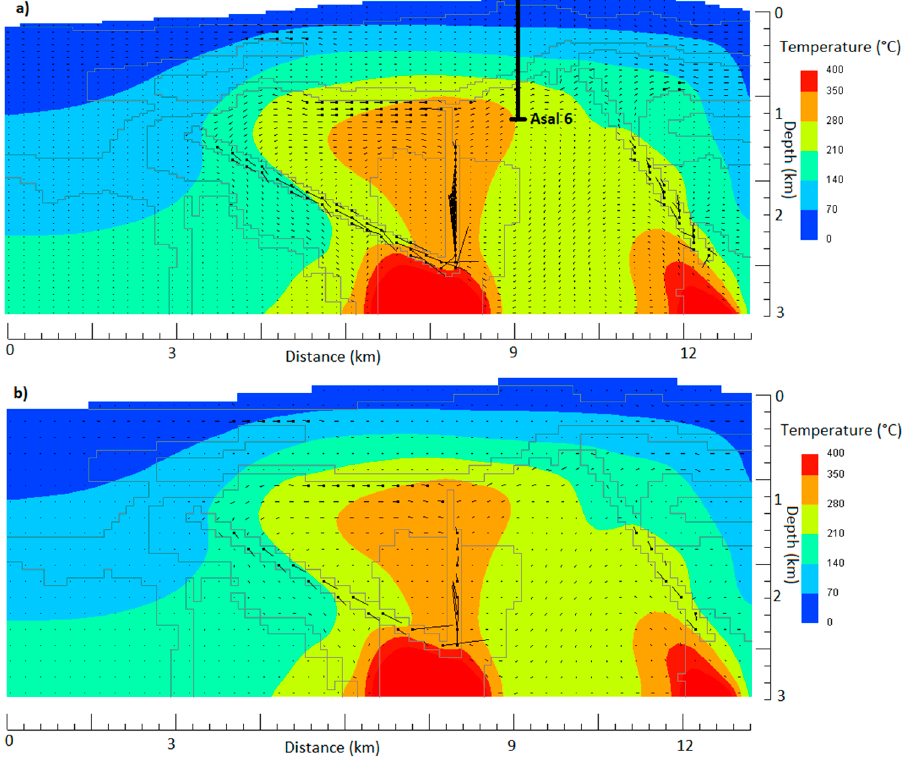
Figure 6. Simulated temperature and flow vectors at time equal to 100,000 years in scenario 1. The direction of flow is from the point to the end of the straight lines. The length of each line indicates the water flow vector magnitude, where 1.2 km = 1 × 10 − 5 g (s -1 cm -2 ). ( a ) Results with a grid of 100 × 100 and initial time step of 0.001 year. ( b ) Results with a grid of 40 × 100 and initial time step of 0.01 year.